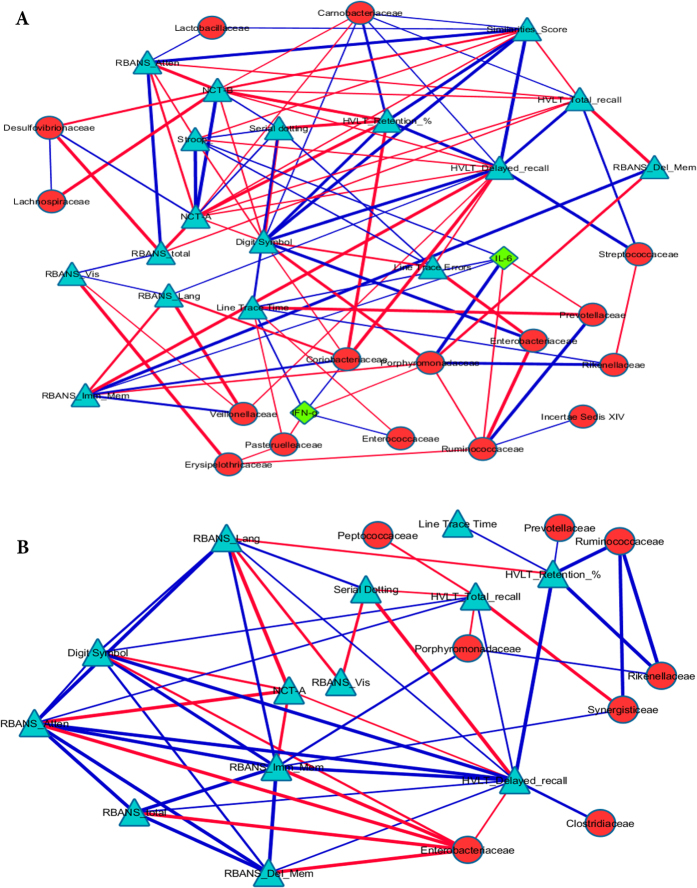
Correlation network analysis.Correlation networks were visualized in Cytoscape. The nodes are microbiota (red circles), cognitive tests (blue triangles) and inflammatory cytokines (green diamonds). Edges joining the nodes are color and size-coded. Blue edges indicate a positive (r > 0.6) and red lines indicate a negative (r < −0.6) correlations while thicker lines indicate a higher significance beyond p < 0.01. RBANS: Repeatable battery for assessment of neuropsychological status, Imm_Mem: immediate memory domain, Del_Mem: delayed memory domain, Att: Attention domain, Vis: Visuo-spatial domain, Lang: Language domain, HVLT: Hopkins Verbal Learning test, Retention %: retention index, NCT-A: number connection test −A, NCT-B: number connection test-B, Line trace time: Line tracing test time, Stroop: EncephalApp Stroop total OffTime + OnTime. A low score on serial dotting, NCT-A, NCT-B, Line trace time and Stroop indicate good performance while a high score on the remaining cognitive tests indicate a good performance. (A) Correlation network for cirrhotic elderly subjects. Significant positive correlations were found between autochthonous bacteria (Ruminococcaceae, Lachnospiraceae) and good cognition and lower systemic inflammation while the reverse was seen for Enterobacteriaceae and Porphyromonadaceae. Lactobacillaceae, Carnobacteriaceae and Streptococcaceae, all of which belong to Lactobacillales and are higher in cirrhotic compared to non-cirrhotic individuals, were associated with good cognitive performance. As expected most cognitive tests were linked with each other in the expected directions. (B) Correlation network for non-cirrhotic elderly subjects. Significant positive correlations were seen between Ruminococcaceae and good cognition and negative ones between Enterobacteriaceae and cognitive performance. Peptococcaceae and Synergistaceae, which were higher in non-cirrhotics compared to cirrhotics, were actually associated with a poor cognitive performance. The correlations of Porphyromonadaceae were largely associated with poor cognitive performance.